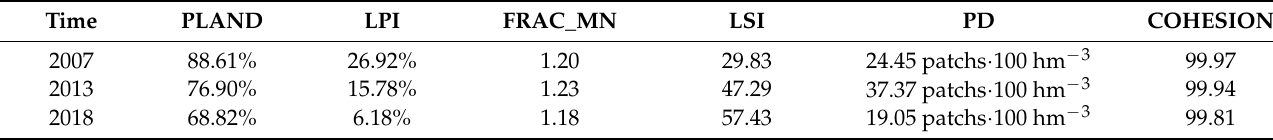
Figure 2. The classification of GI. Table 3. The changes of overall GI indicators